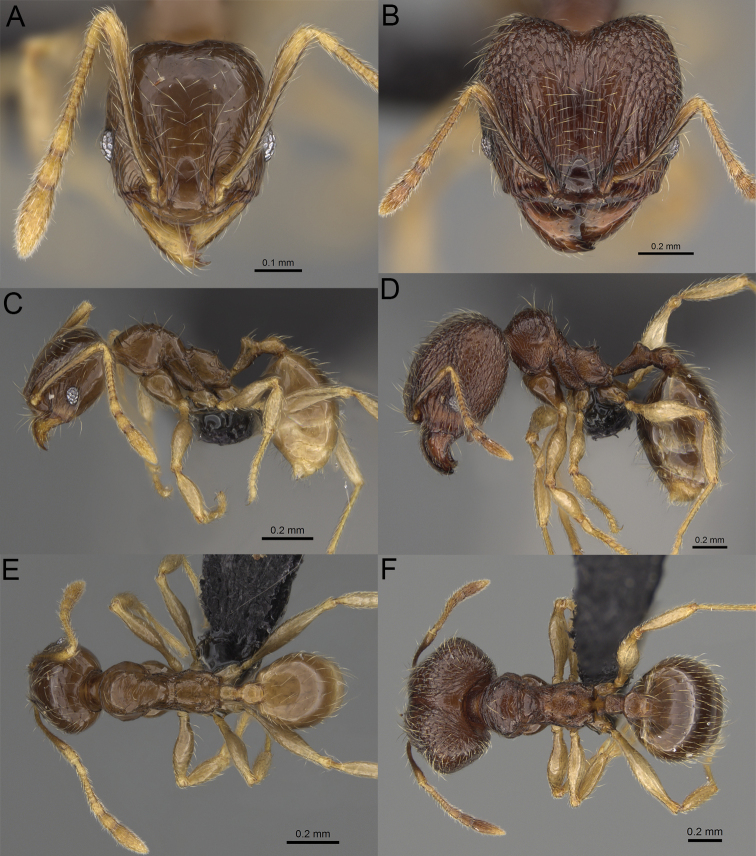
Pheidole
volontany Forel, full-face view (A), profile (C), and dorsal view (E) of minor paratype worker (CASENT0491862) and full-face view (B), profile (D), and dorsal view (F) of holotype major worker (CASENT0491861).